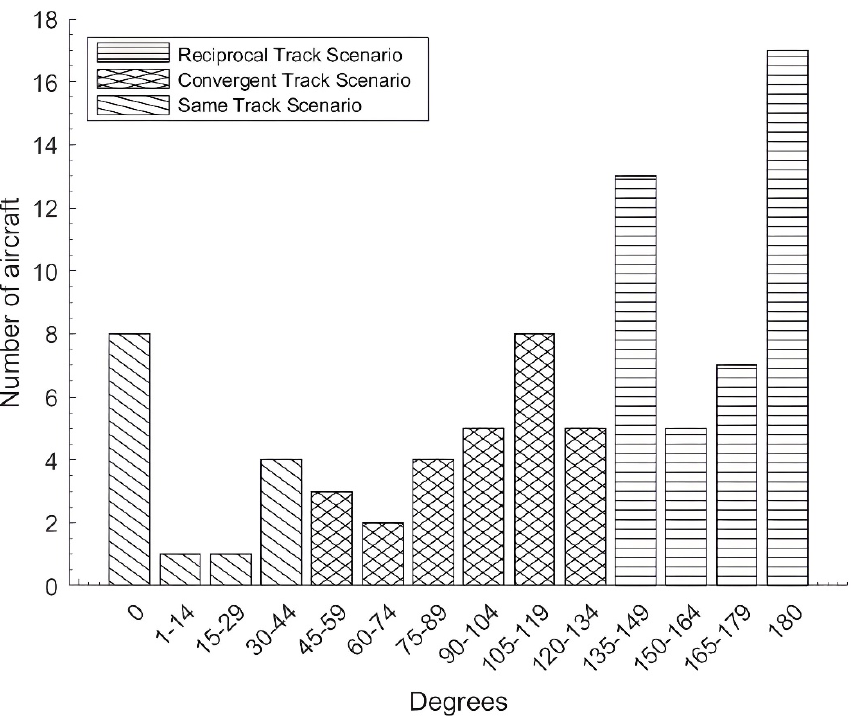
Figure 7 . Angles between tracks for the different encounter geometries. Figure 7. Angles between tracks for the different encounter